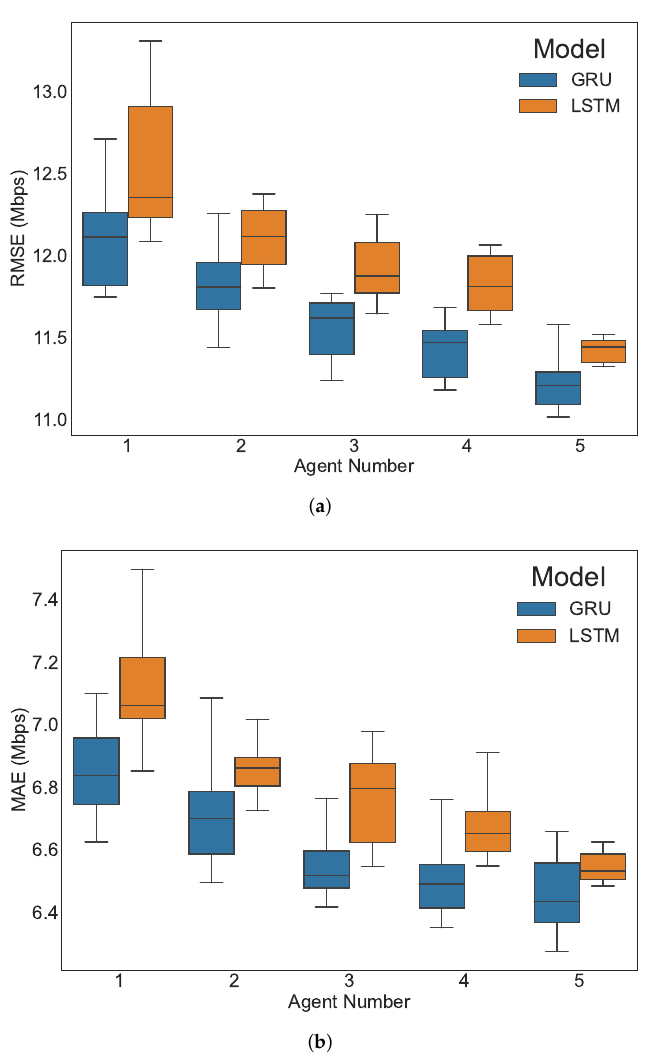
Figure 4. The evaluation results with different agent numbers. ( a ) RMSE; ( b )